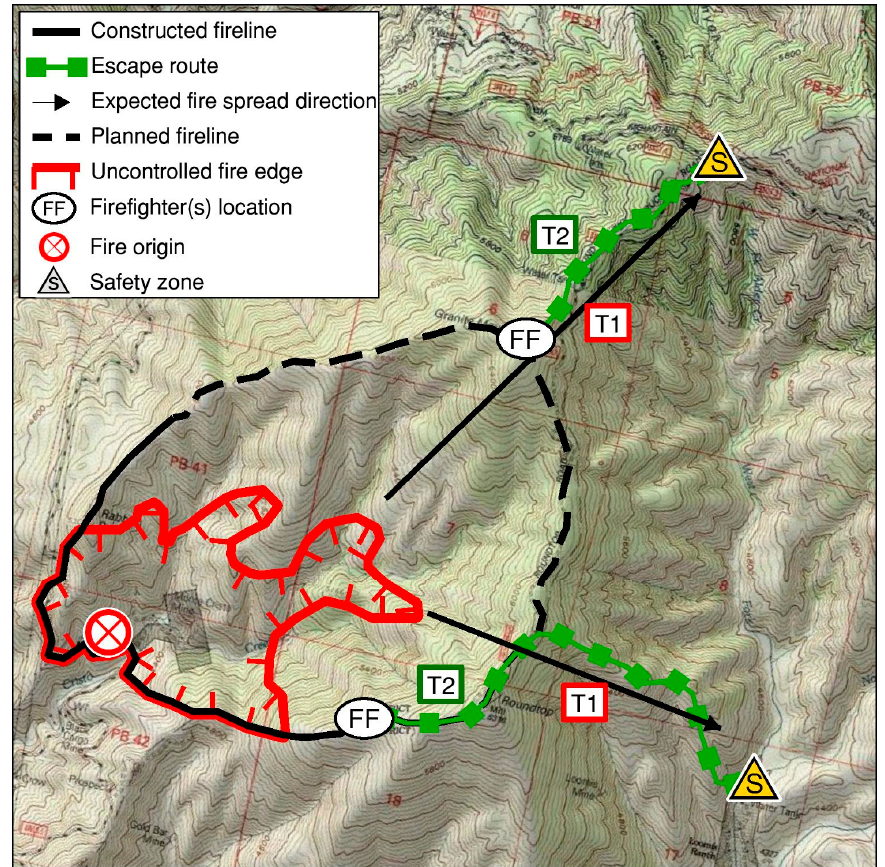
Figure 1. The concept of the Margin of Safety adapted from Beighley [5]. T1 represents the time required for the fire to reach a safety zone and T2 is the time required for firefighter(s) (FF) to reach the same safety zone. In order to create a Margin of Safety T1 should exceed T2.